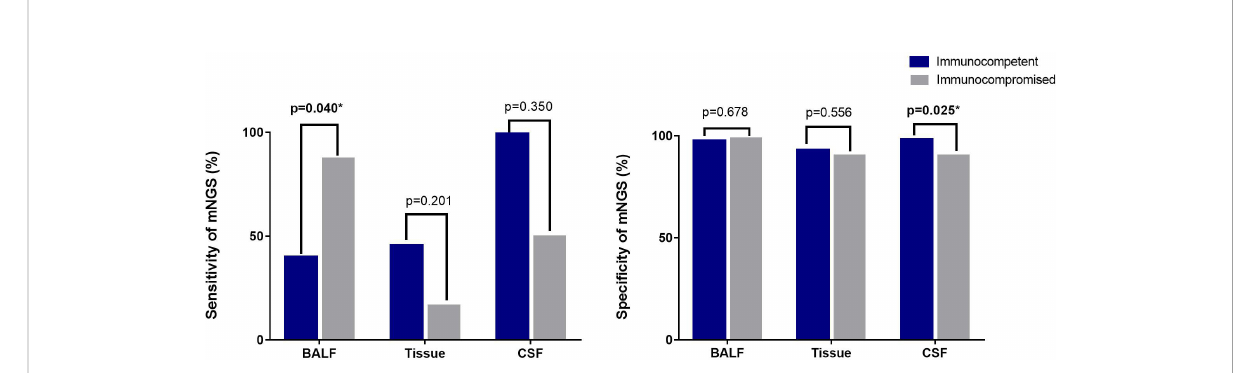
FIGURE 3 Sensitivity and speci fi city of mNGS from different samples by different immune statuses. The sensitivity of mNGS with sputum from 7 immunocompetent patients was 0%, and the positive rate of 3 sputum samples of immunocompromised patients was 33.33%. Sensitivity of mNGS from blood was not detected in immunocompetent patients. Two immunocompromised patients with disseminated cryptococcal infections were evaluated for mNGS of blood and the positive rate was 50%. The speci fi city of mNGS for sputum samples was 97.31% in immunocompetent patients and 98.79% in immunocompromised patients. The speci fi city of blood samples was 99,32% in immunocompetent patients and was 98.01% in immunocompromised patients. *means results has statistically signi fi cant.